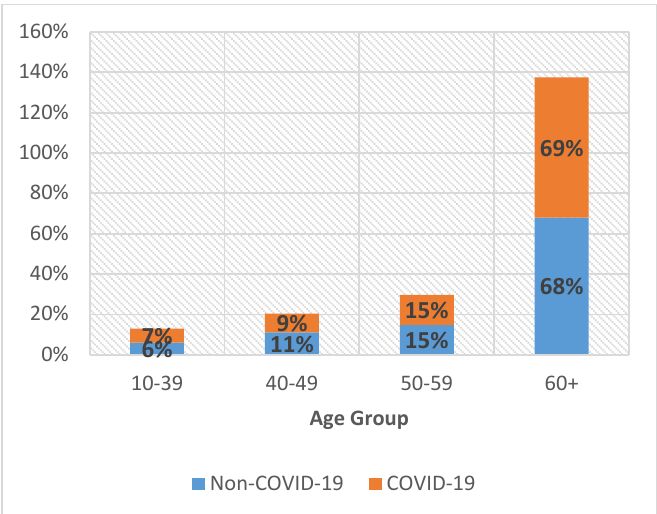
Figure 1. Prevalence of mortality among individuals with laboratory-confirmed SARS-CoV-2 according to age group ( p –value = 0.979).